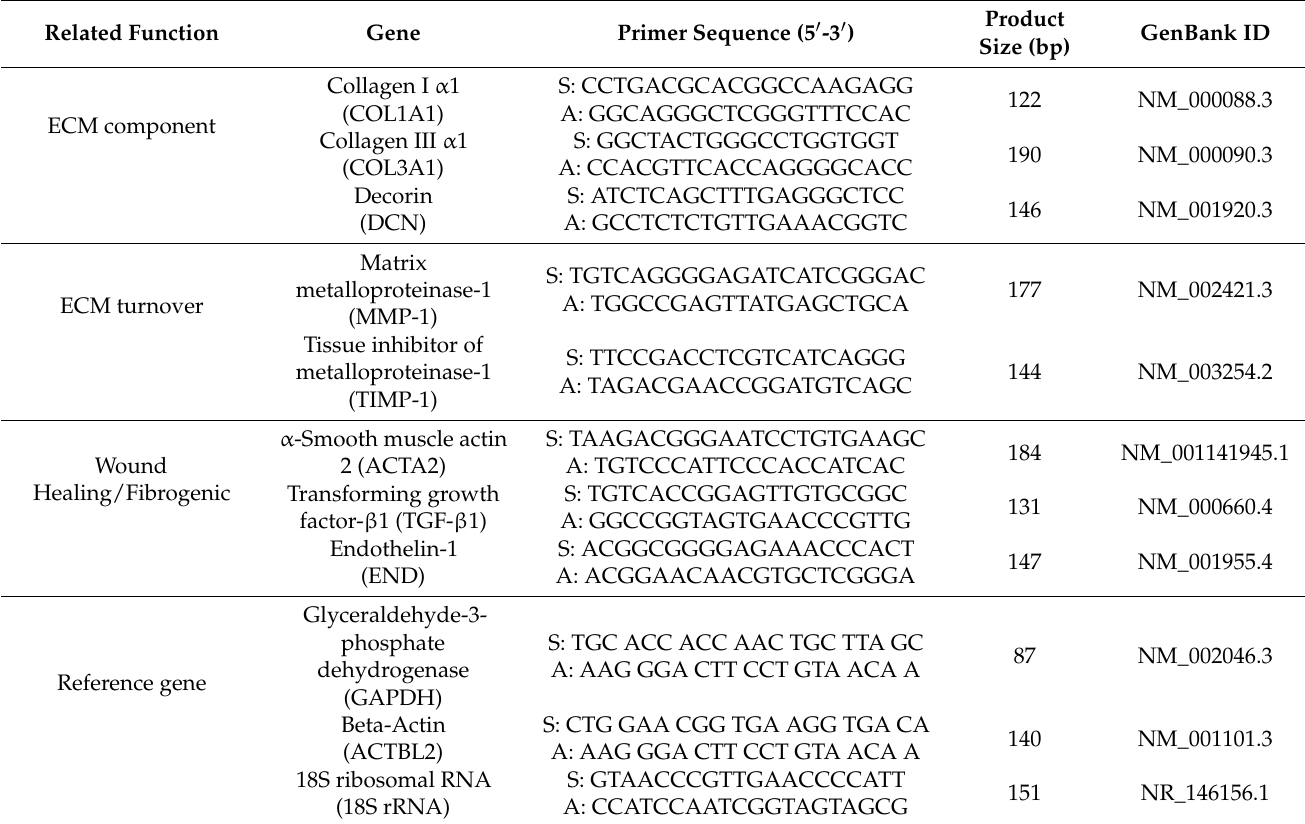
Table 2. Genes and primers used in gene expression analysis. Sequence of sense (S) and antisense (A) primers used in the real-time RT-PCR of reference and target genes. Base pairs